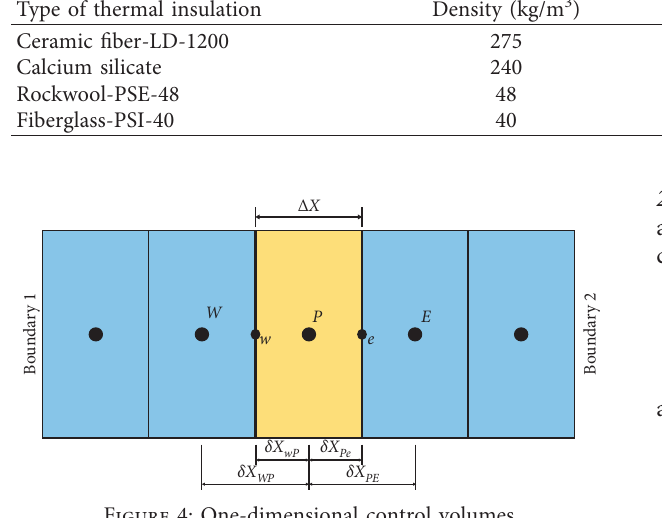
Figure 4: One-dimensional control volumes.